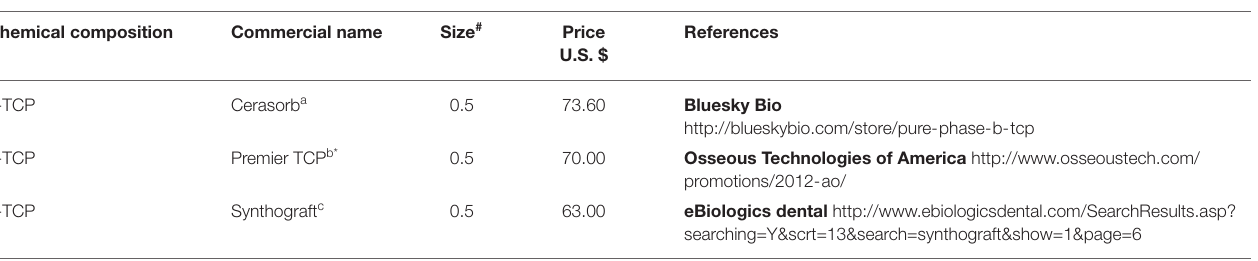
TABLE 4 | Price ratio of β - TCP implants with brand names and granule